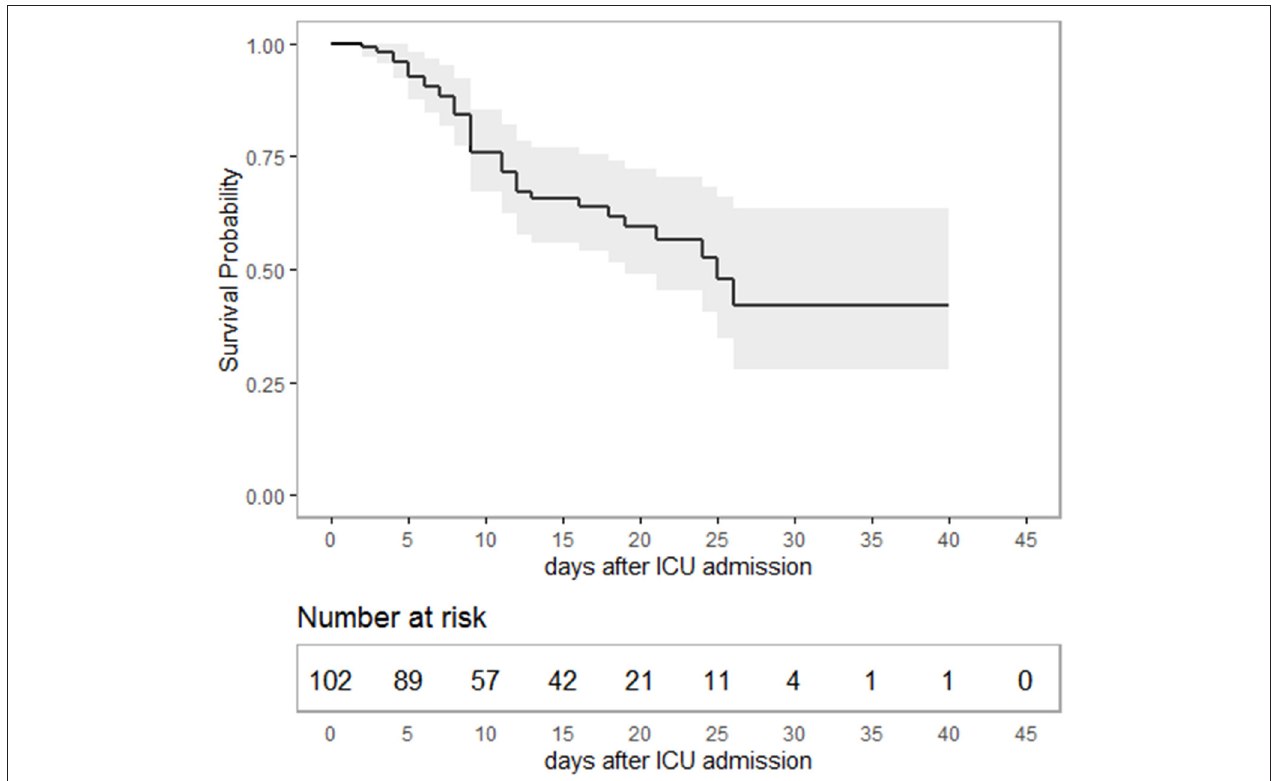
FIGURE 1 | Kaplan-Meier-plot showing survival probability as a function of time in intensive care. Overall, 65% (95%-CI 55.6–73.5) of the patients survived ICU treatment with a median duration of 11 (IQR: 7–19) days. The study period ended with ICU discharge or death, respectively. Hence, survival data are terminally censored resulting in a horizontal line on the far